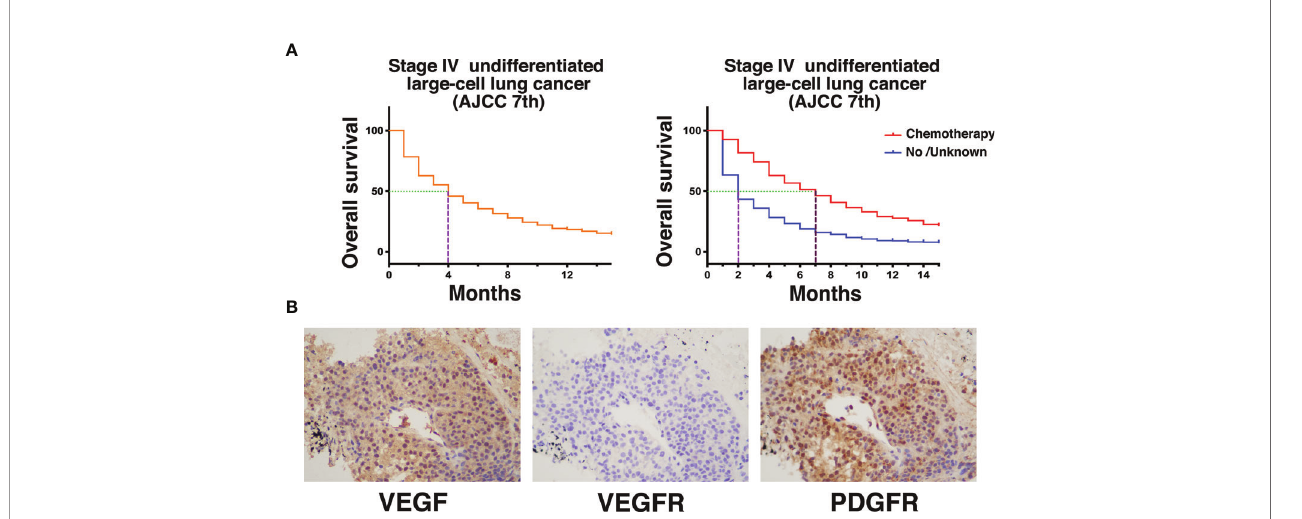
FIGURE 3 | (A) Kaplan – Meier (KM) analysis of survival of patients with stage IV (AJCC 7 th edition) undifferentiated large-cell lung cancer from the SEER database after 2010. (B) Retrospective examination of the expression of angiogenesis-related genes and anlotinib targets by immunohistochemistry [VEGF (++); VEGFR ( − ); PDGFR (+++)].